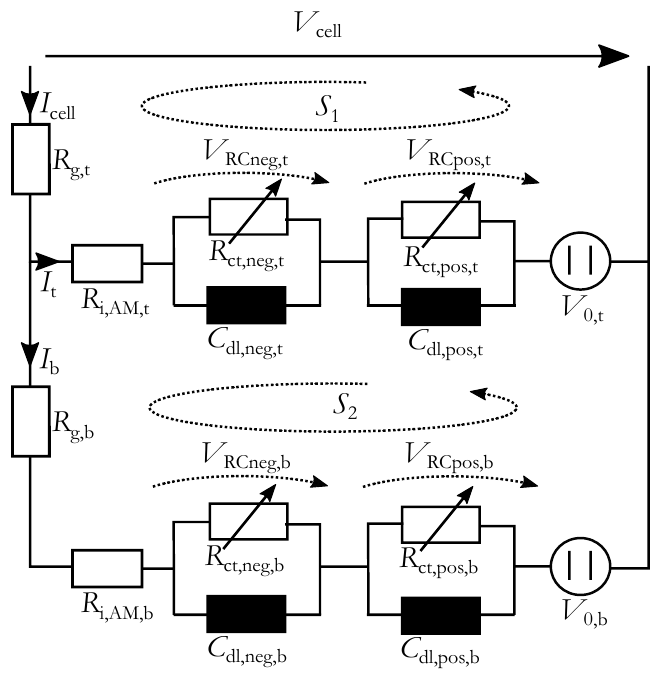
Figure 3. Spatially-resolved equivalent electrical circuit (srEEC) with two layers to simulate an inhomogeneous current